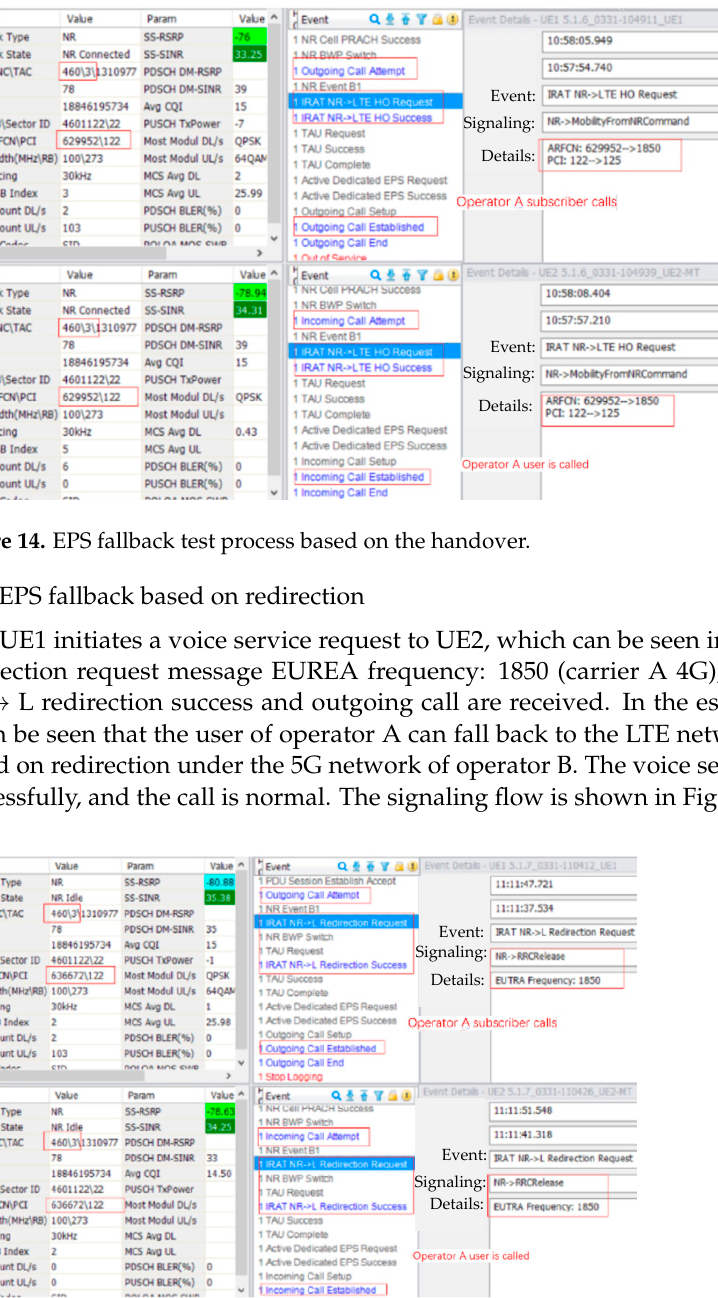
Table 3. EPS fallback call setup delay.